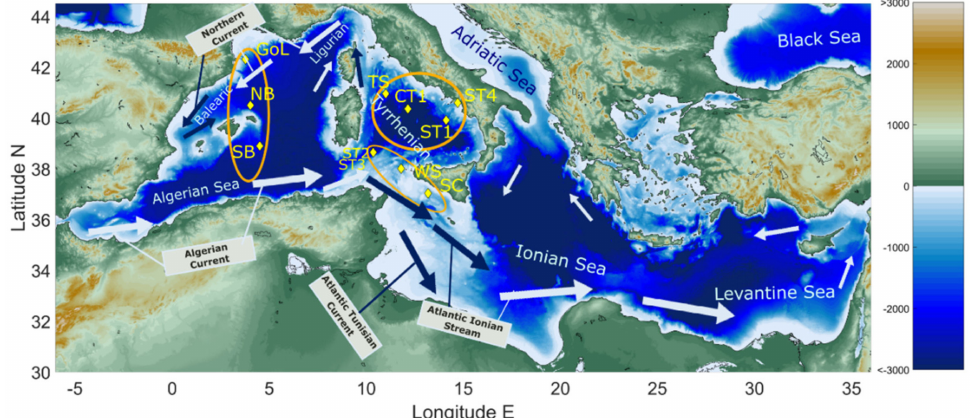
Figure 1. Geographical distribution of G. truncatulinoides abundance (%) in core top samples of the Mediterranean Sea [38]; MARGO database from Kucera et al. (2005) [39] was modified in this work with additional core top samples from Nextdata Project. The orange circles that divide the study area into three sectors are used for the oceanographic discussions in the